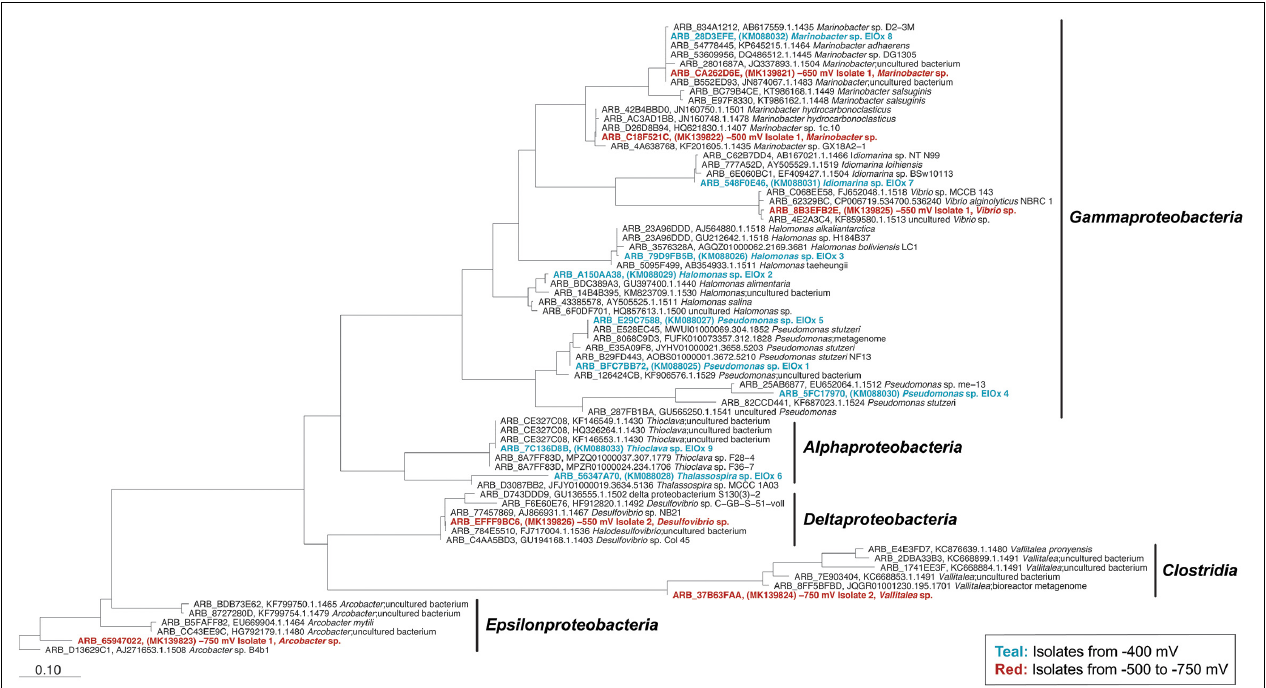
FIGURE 4 | Phylogenetic tree constructed for all isolates based on full-length 16S rRNA gene sequences. The 16S rRNA sequences from isolates obtained from the pilot study are shown in teal (Rowe et al., 2015). The 16S rRNA sequences from strains isolated from this study are shown in red. The tree was constructed using the Randomized Axelerated Maximum Likelihood (RAxML) method. The scale bar indicates nucleotide substitutions computed using RAxML in ARB. GenBank accession numbers for isolates are indicated in parentheses. The Arcobacter sp. B4b1 (ARB_D13629C1) was selected as the tree